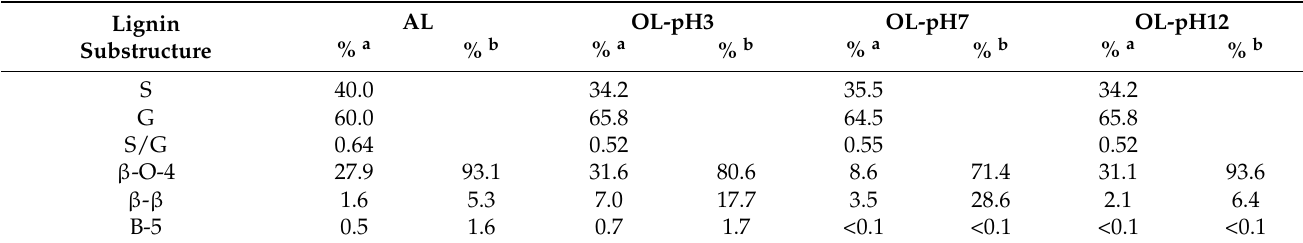
Table 3. Semi-quantitative information for lignin subunits and inter-unit linkages in the untreated and ozone pretreated alkali